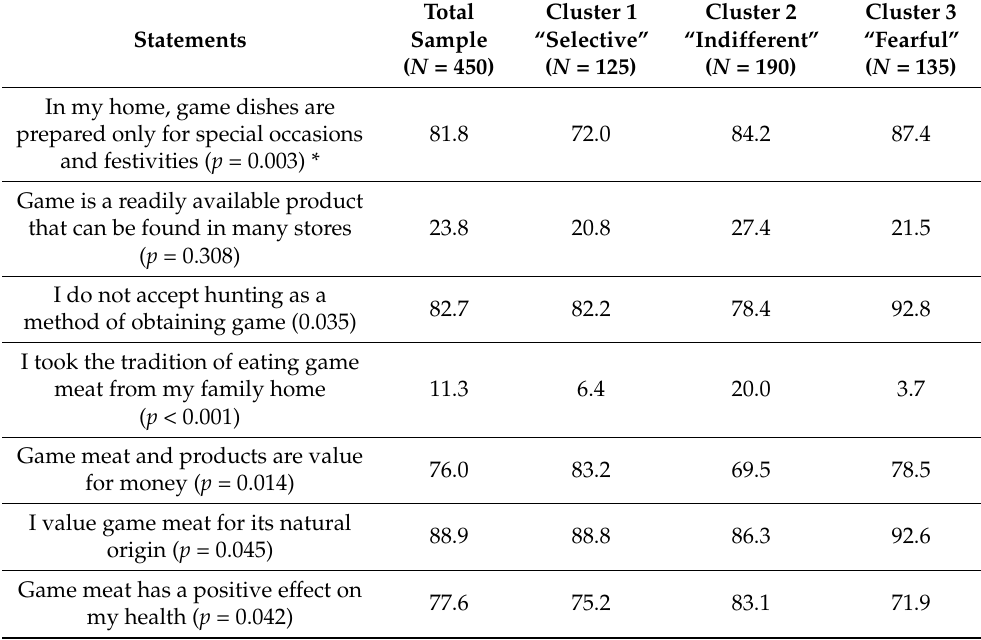
Table 3. Clusters’ profile according to the participants’ attitudes towards game meat (%; N = 450,